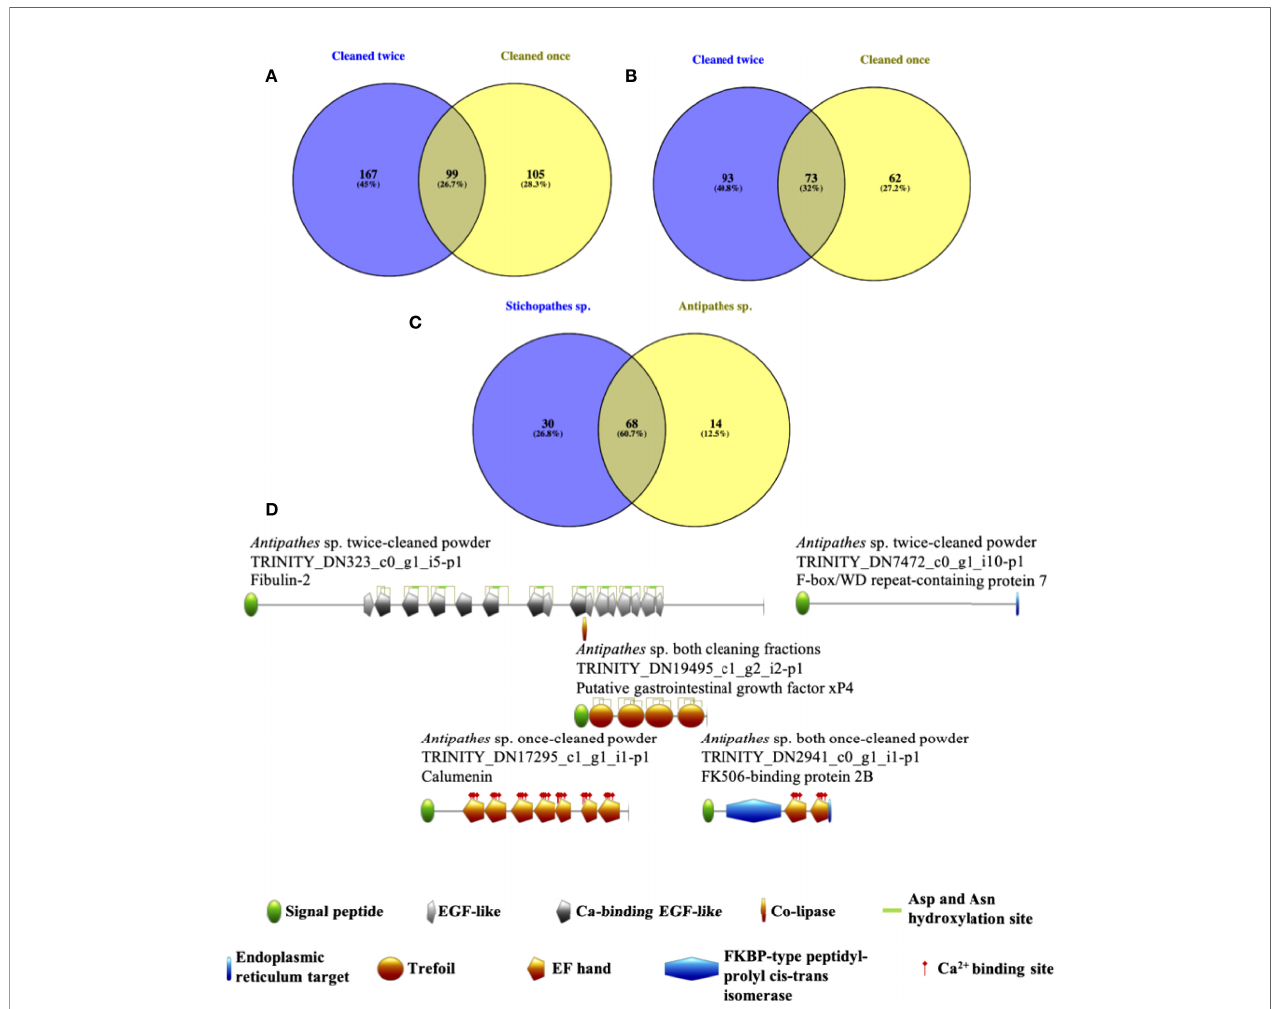
FIGURE 2 | For both Antipathes (A) and Stichopathes (B) we observed ~30% overlap in protein detection between skeleton cleaned only before grinding (yellow) and skeleton clean both before and after grinding (purple). Unique proteins were also found in both fractions. Further, for both species, the largest number of proteins were found in the twice-cleaned fractions (purple, a & b). 60.7% of detected proteins with reciprocal best BLAST hits between the two species were observed in both species (C) across the various cleaning fractions. (D) Predicted domains in proteins extracted from black coral skeleton using chitinase. Only proteins that were completely predicted, display a proposed signal peptide, and are biased toward key amino acids were considered. Although several Stichopathes skeletal proteins meet these criteria, none are predicted to have any